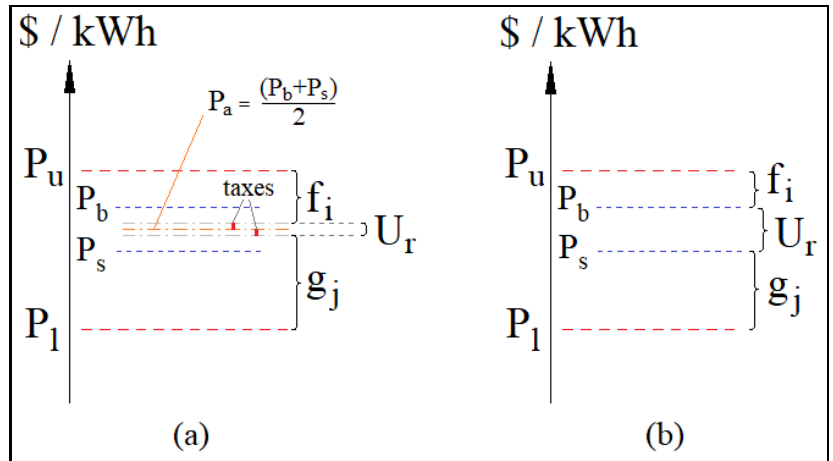
Figure 3. When the price of the purchaser equals or surpasses the price of the seller, P b ≥ P s , ( a ) an average price P a is calculated in the state-of-the-art approaches of [35,36] and taxes are applied over the surpluses ( P b − P a ) and ( P a − P s ) . ( b ) The proposed protocol, where the prices yield the welfares f i and g j , which are complementary with regards to the welfare of the utility U r = P b − P s , such that f i + g j + U r = P u − P l